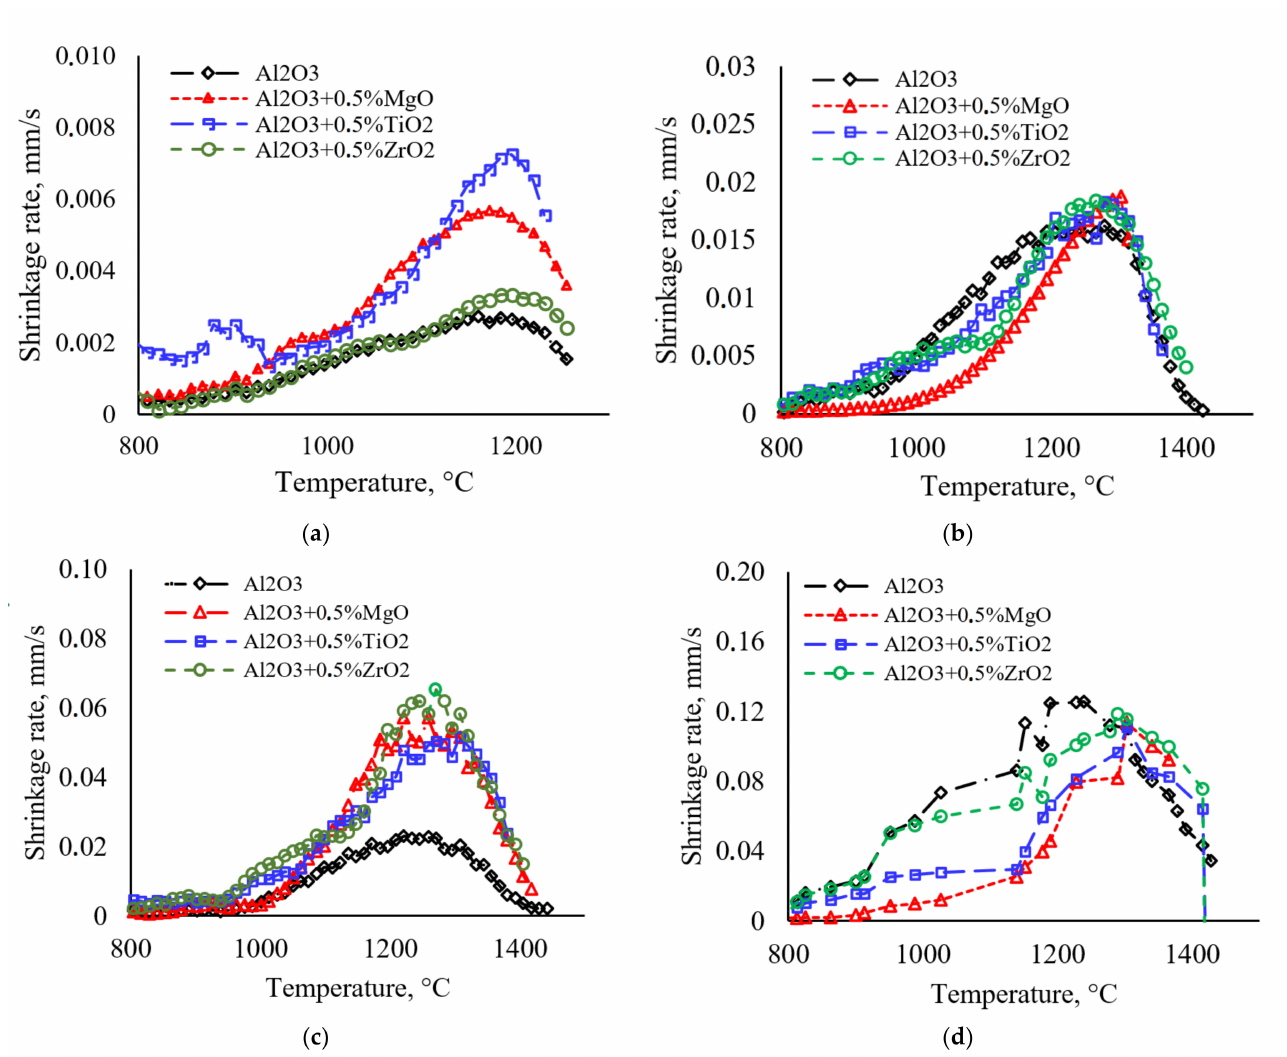
Figure 3. Shrinkage behaviors S ( T ) at: ( a ) 10 ◦ C/min, ( b ) 100 ◦ C/min, ( c ) 350 ◦ C/min, ( d ) 700 ◦